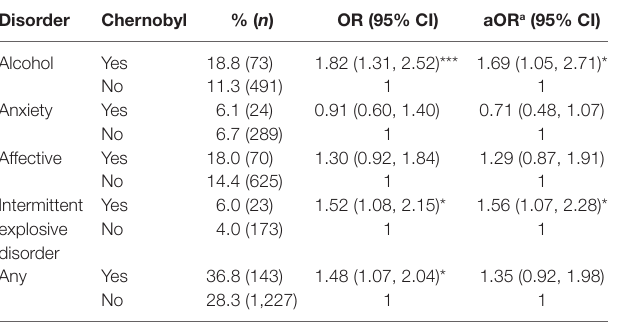
TaBle 2 | Mental health disorder prevalence after Chernobyl Disorder